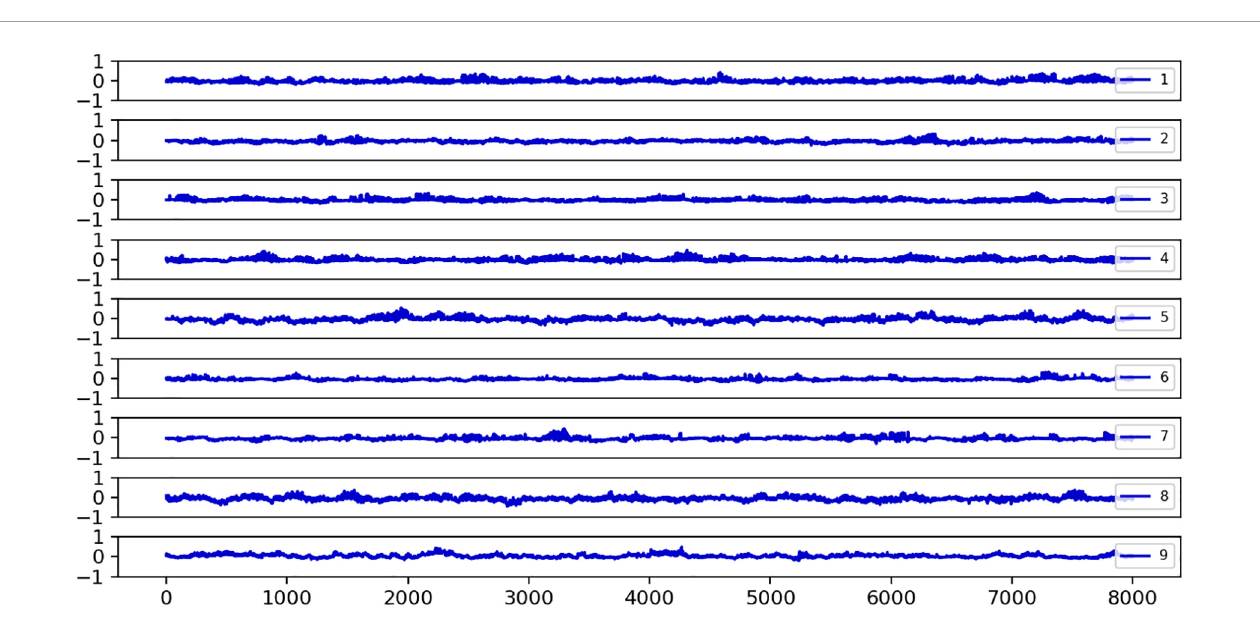
local oscillations than for slow global oscillations, and it recovers to pre-seizure levels after a seizure. As a result, changing strong local oscillations and slow global oscillations in the functional network